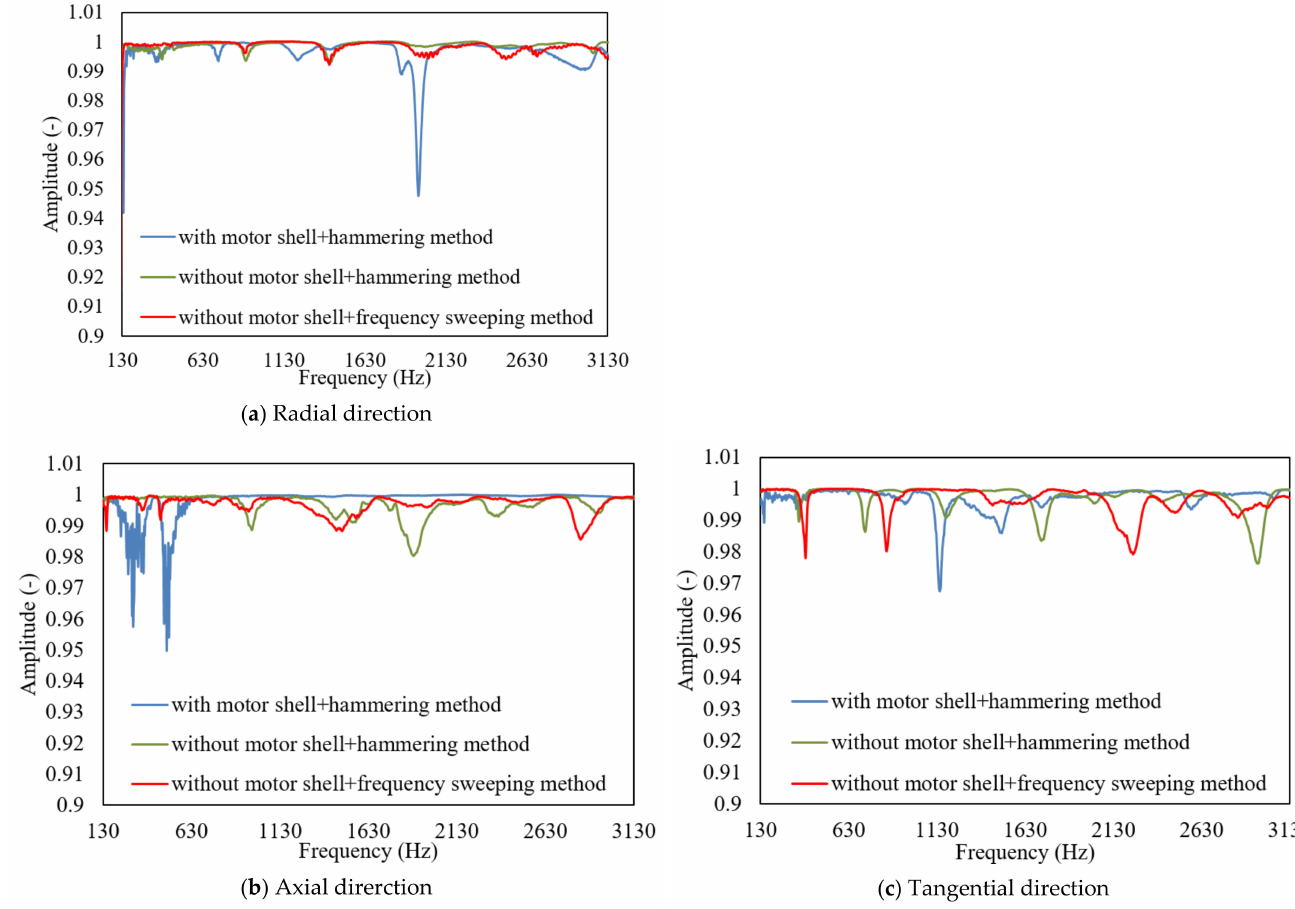
Figure 3. Coherence function curves at a certain stimulus response